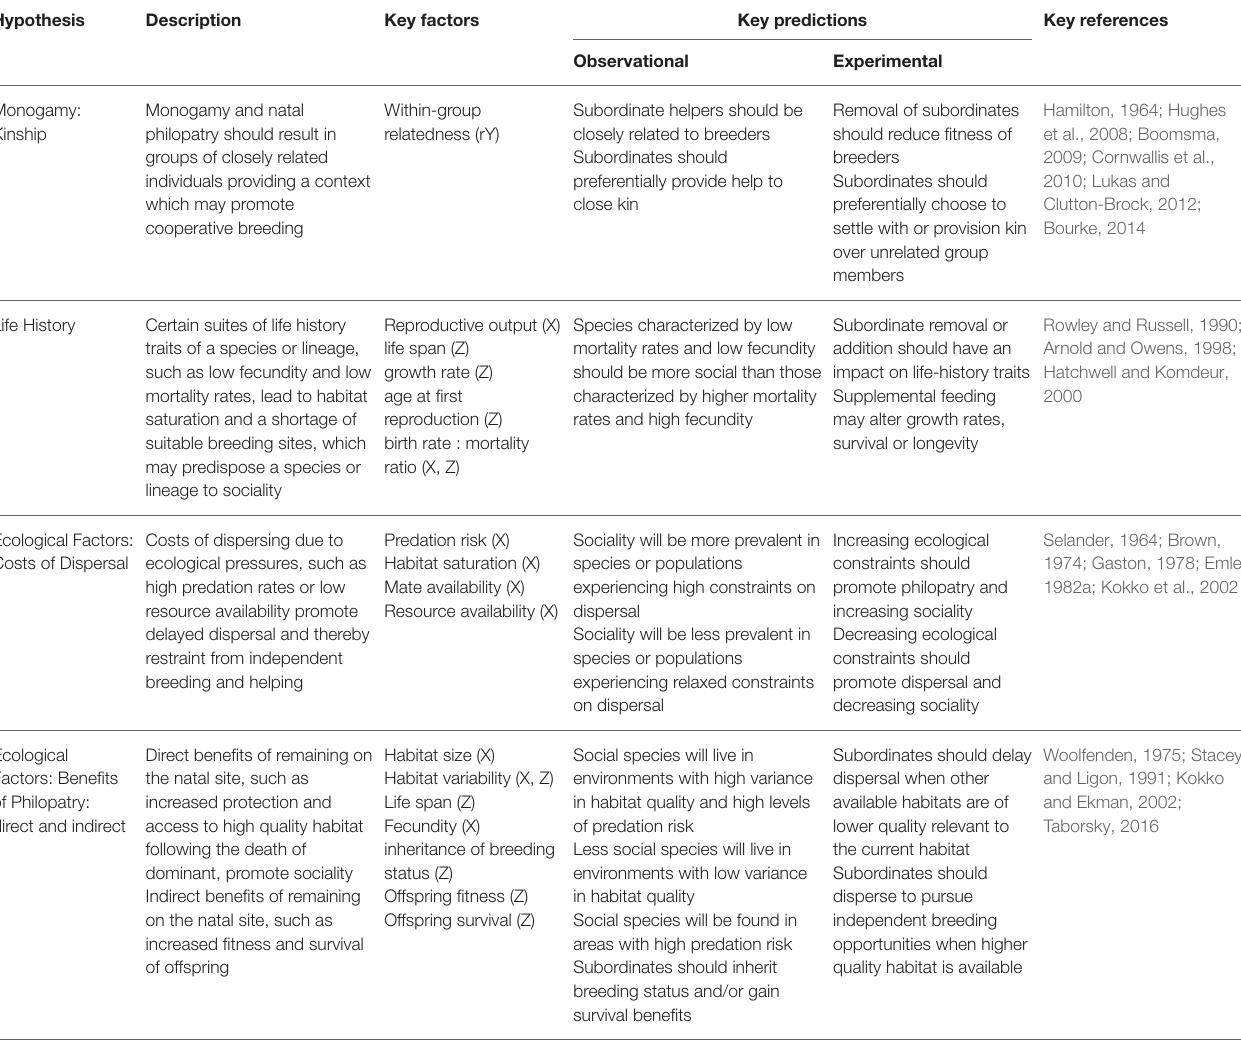
TABLE 1 | Four of the major hypotheses of Cooperative Breeding Theory and the respective key factors proposed to influence the evolution of sociality.